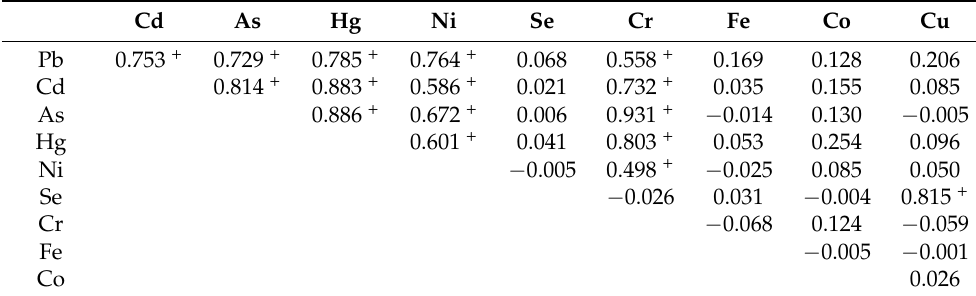
Figure 1. Boxplot distribution of toxic metals and micronutrients in the tested food supplements, for: ( a ) Pb, ( b ) Cd, ( c ) As, ( d ) Hg, ( e ) Ni, ( f ) Se, ( g ) Cr, ( h ) Fe, ( i ) Co, ( j ) Cu and ( k ) Zn content. Values presented in bars with the different letters are statistically different ( p < 0.05) by means of Tukey’s HSD test. Letters are same with the subfigure’s title. Table 3. Correlation matrix of toxic metals and micronutrients in the tested food